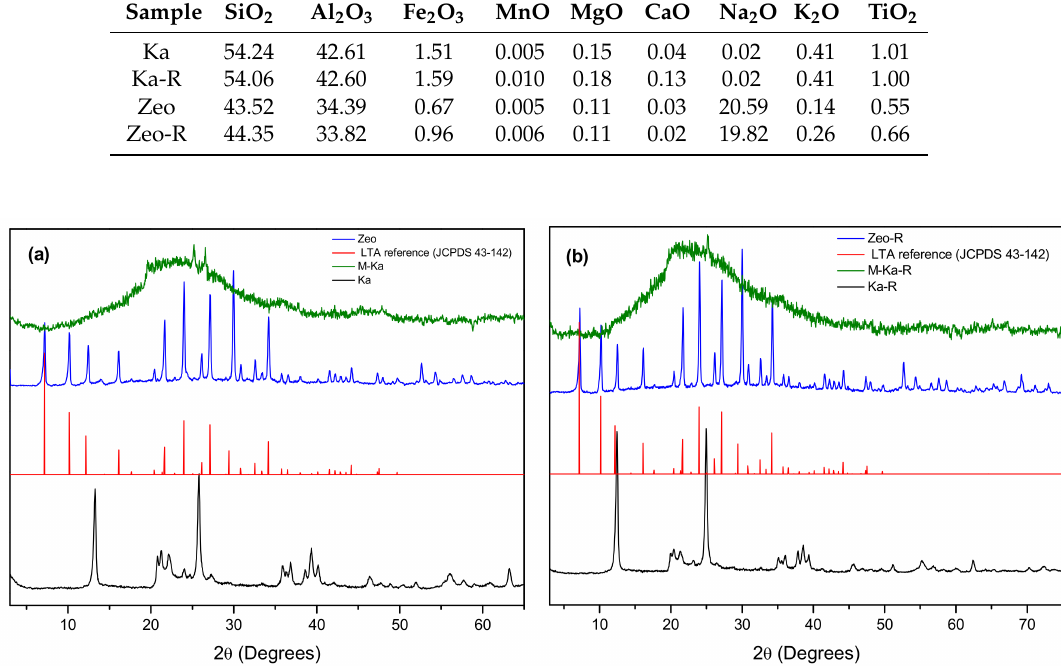
Figure 1. PXRD patterns of the purified parent kaolins Ka and Ka-R, the metakaolins M-Ka and